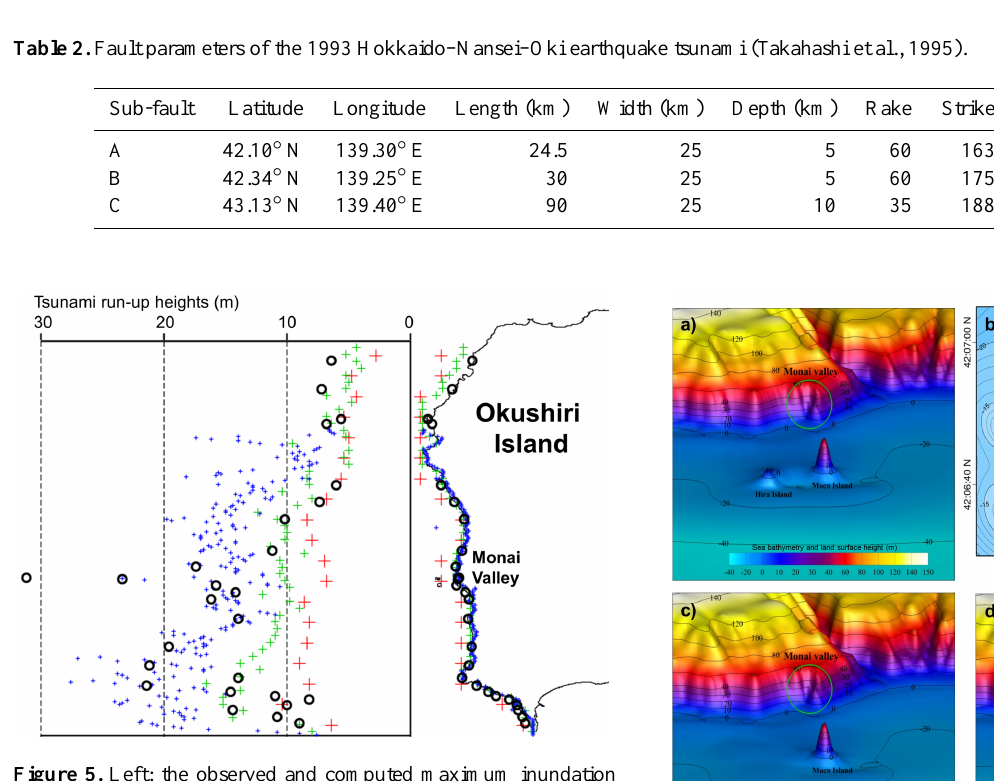
Figure 5. Left: the observed and computed maximum inundation heights; right: the locations of inundation observations (black open circles) and the locations of computation points in the subdomains D1 (red marks), D2 (green marks) and D3 (blue marks) on the west coast of Okushiri Island.